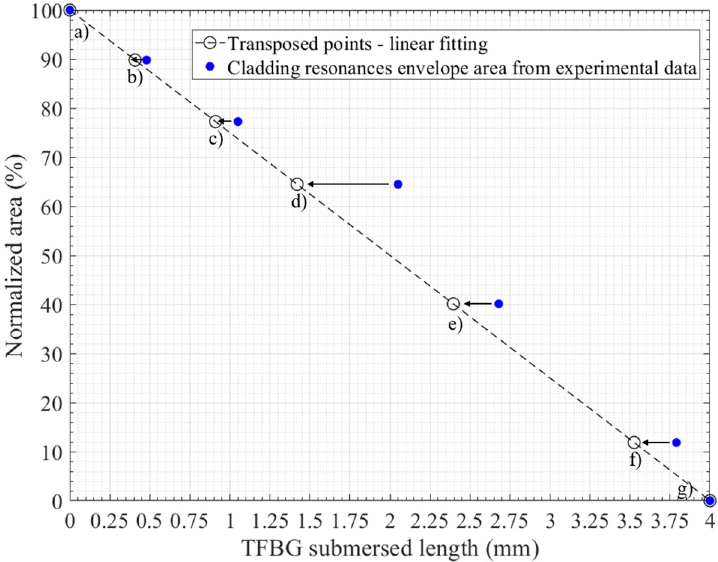
Figure 19. Correction through the TFBG (black circles) of the immersion lengths measured digitally from Figure 18 (blue dots).